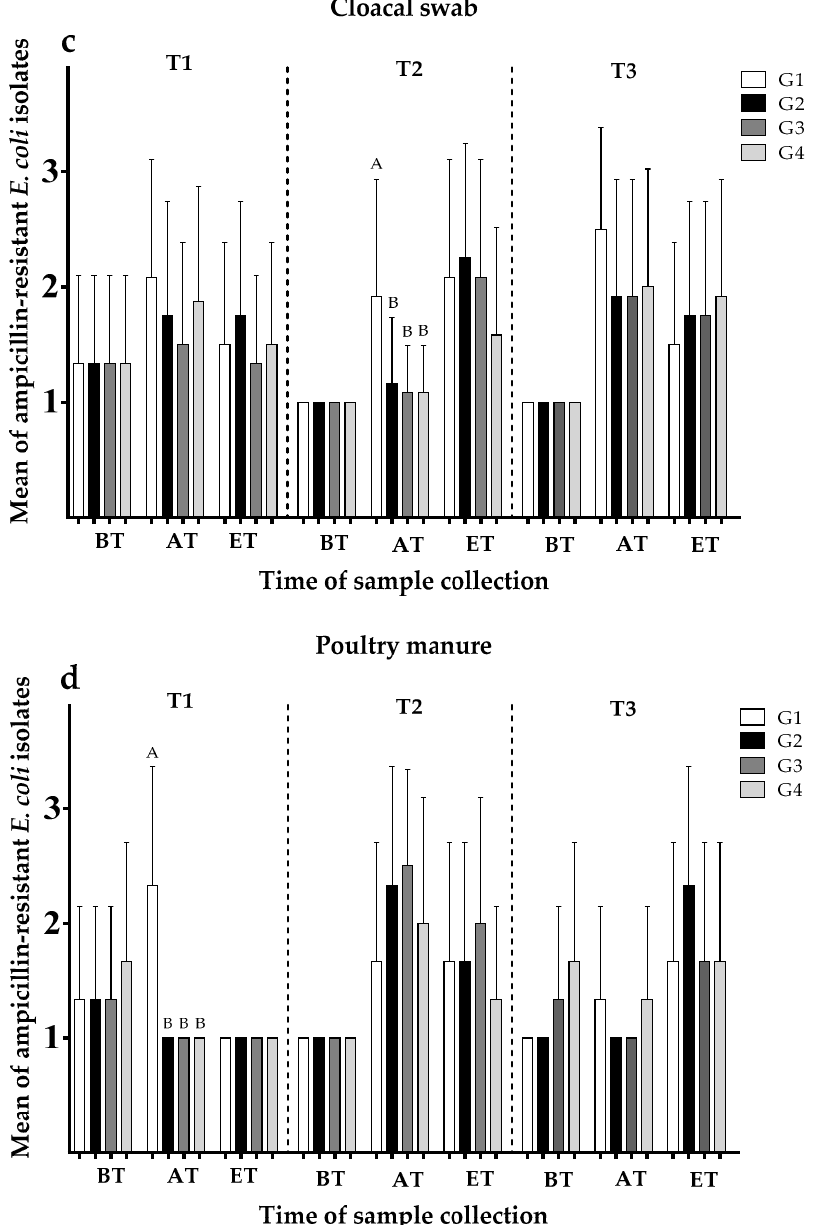
Figure 2. Means of susceptible (=1); intermediate (=2); and resistant (=3) E. coli isolates concerning enrofloxacin resistance in ( a ) cloacal swabs and ( b ) poultry manure samples as well as ampicillin resistance in ( c ) cloacal swabs and ( d ) poultry manure samples before treatment (BT), after treatment (AT) and at the end of trial (ET; cloacal swabs: N = 648; per trial BT: n = 24, AT: n = 96, ET: n = 96; poultry manure: N = 216; per trial BT: n = 24, AT: n = 24, ET: n = 24). T1 = no treatment with antibiotic; T2 = treatment of enrofloxacin via drinking water; and T3 = water (containing enrofloxacin) loss simulation trial. G1 = entire floor pen covered with litter; G2 = floor pen covered with litter and having floor heating; G3 = partially (50:50) slatted flooring including an area that was littered; and G4 = fully slatted flooring with a sand bath (900 cm 2 ). A, B means differ significantly between the groups at one sampling ( p < 0.05).